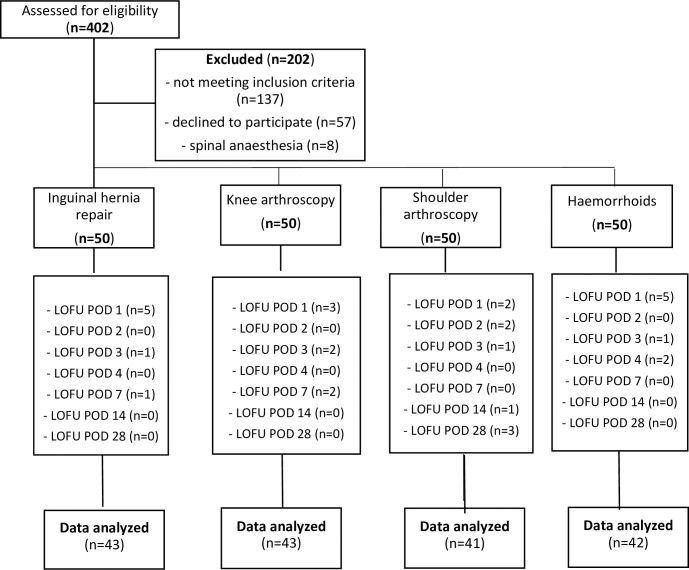
Study flow diagram.LOFU: Loss to follow-up, POD: post-operative day.